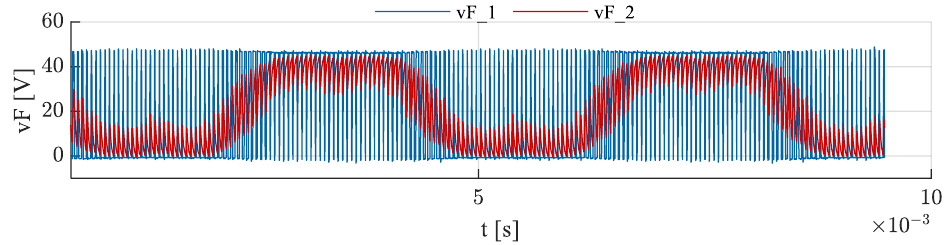
Figure 8. Double zero-sequence SVM during the steady-state six-phase operation: ( a ) PWM references; ( b ) SVM sectors.